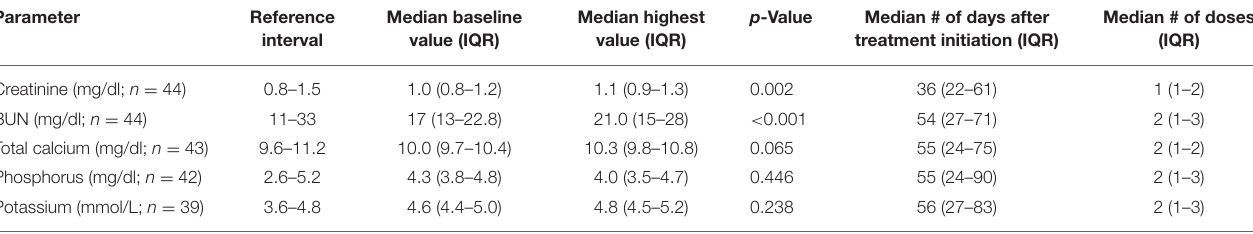
TABLE 1 | Baseline and median highest renal and electrolyte values for dogs following zoledronic acid administration. Parameter